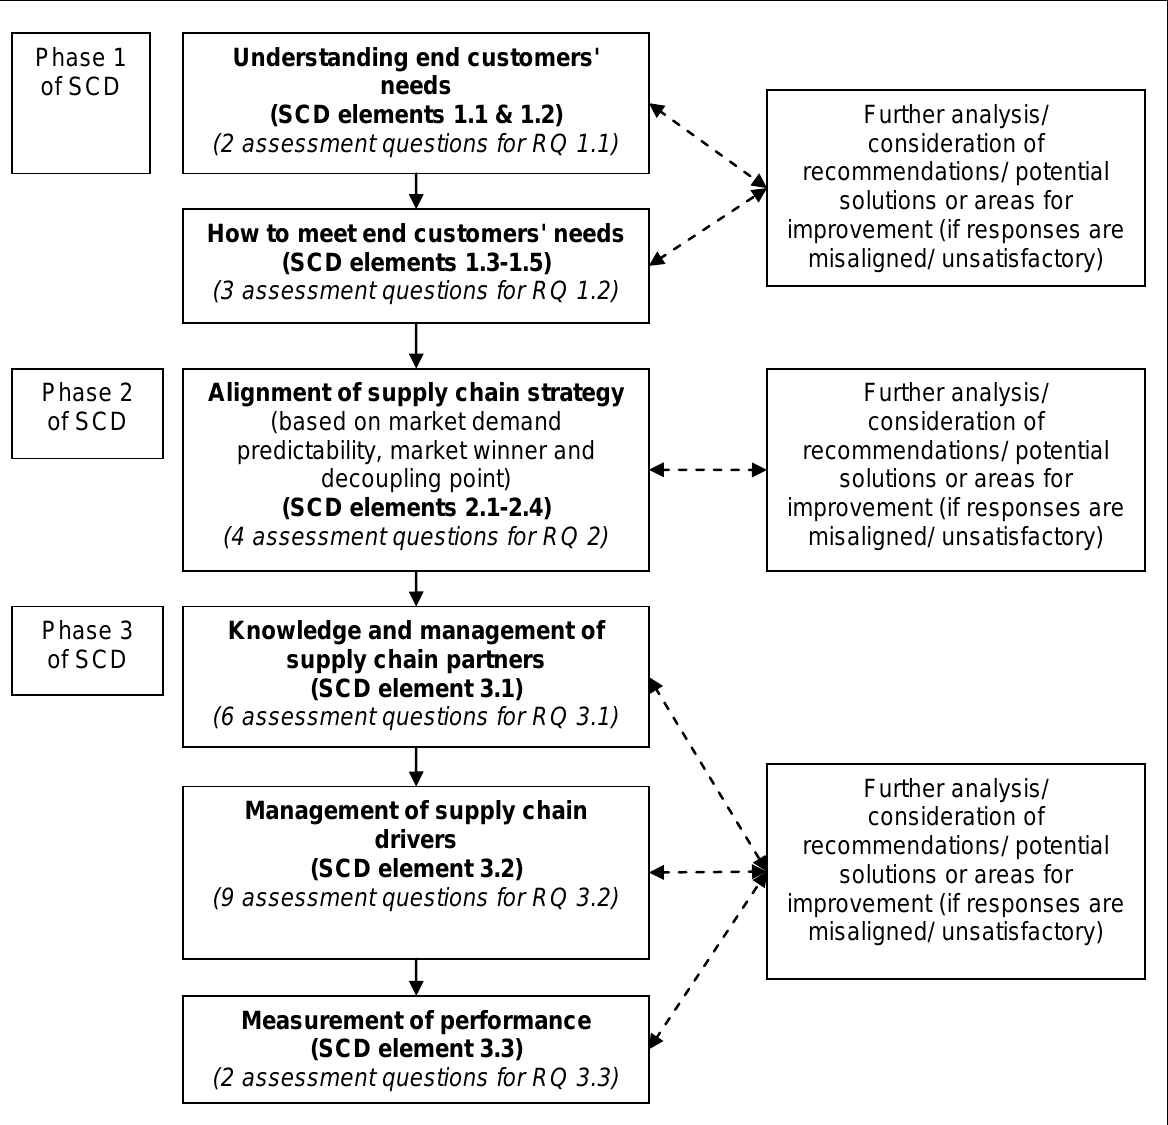
Figure 3: The conceptual framework